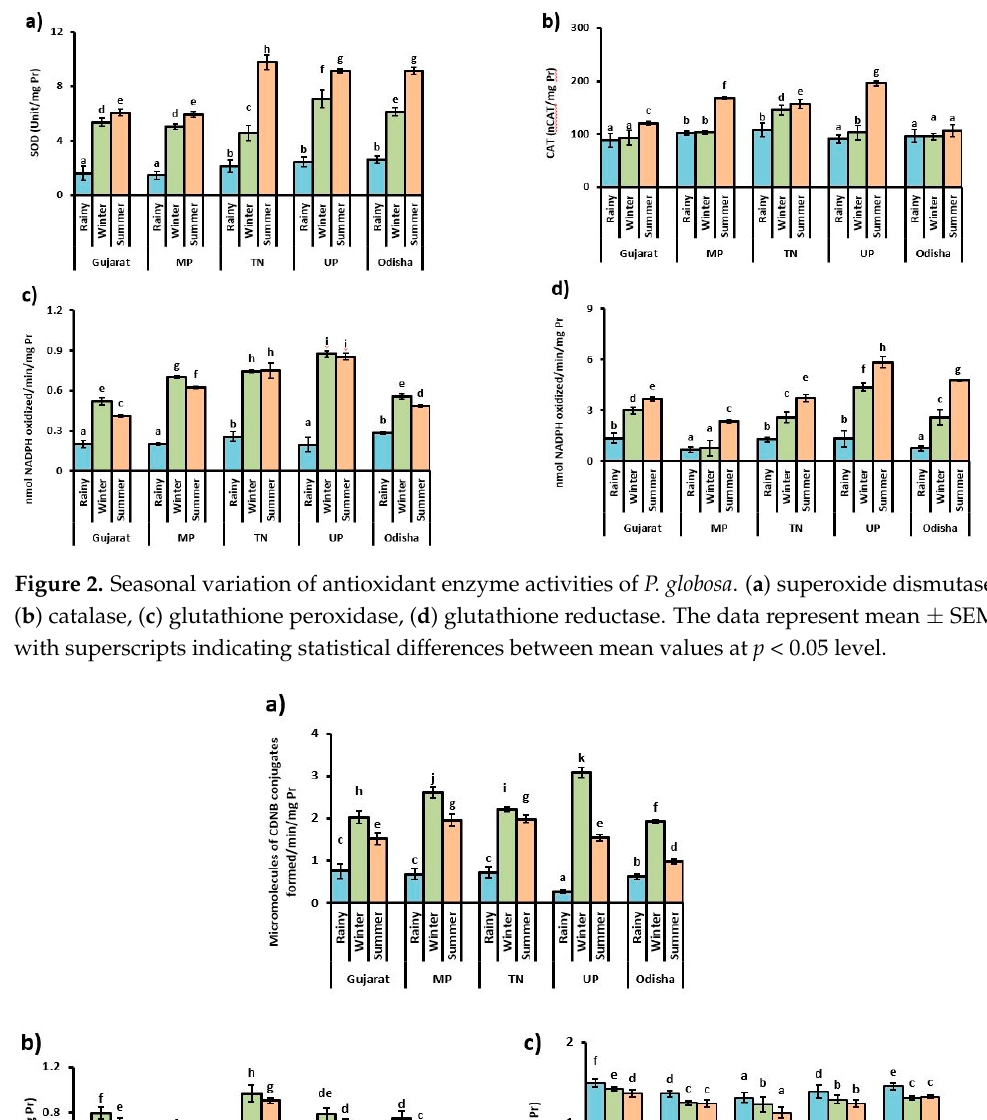
ing the winter season (Figure 5a). Similarly, the highest and lowest SOD+CAT+GPx+GR+GST+AA+GSH values were detected during the summer and rainy seasons, respectively (Figure 5b).